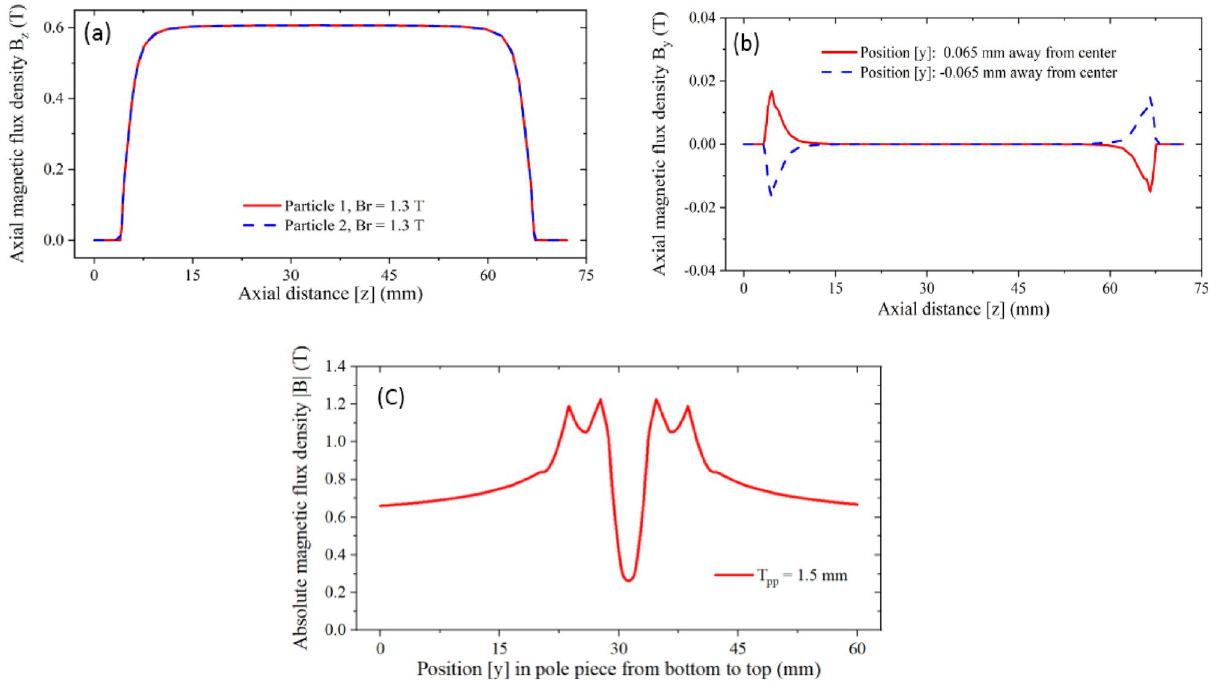
Figure 14. Distribution of the magnetic field intensity with Br = 1.3 T. ( a ) Axial field distribution. ( b ) Transverse field distribution By in the z-direction. ( c ) Absolute values of the field distribution inside the pole piece.